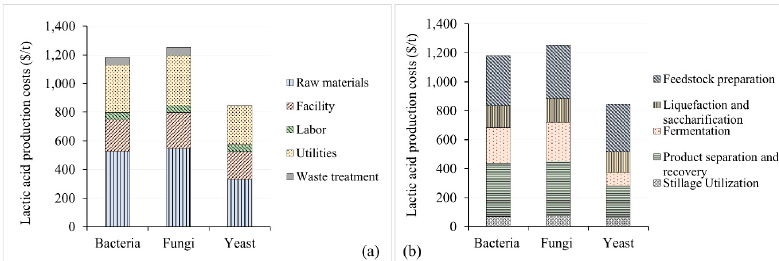
Figure 4. Lactic acid production costs for the facility producing 100,000 t/y of lactic acid from corn grain using different fermentation pathways. ( a ) Contributions based on different process requirements, and ( b ) contributions based on different unit operations.